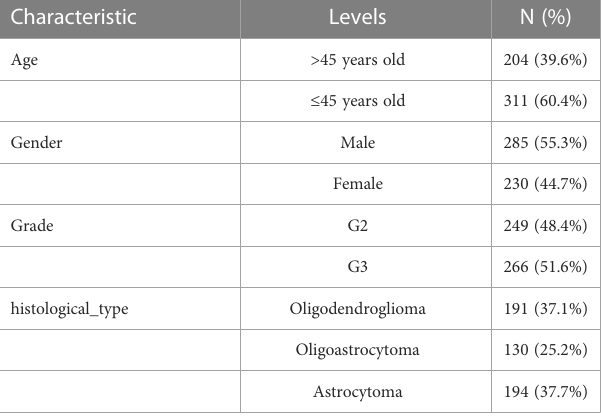
TABLE 1 Baseline Data Sheet for the Cohort of